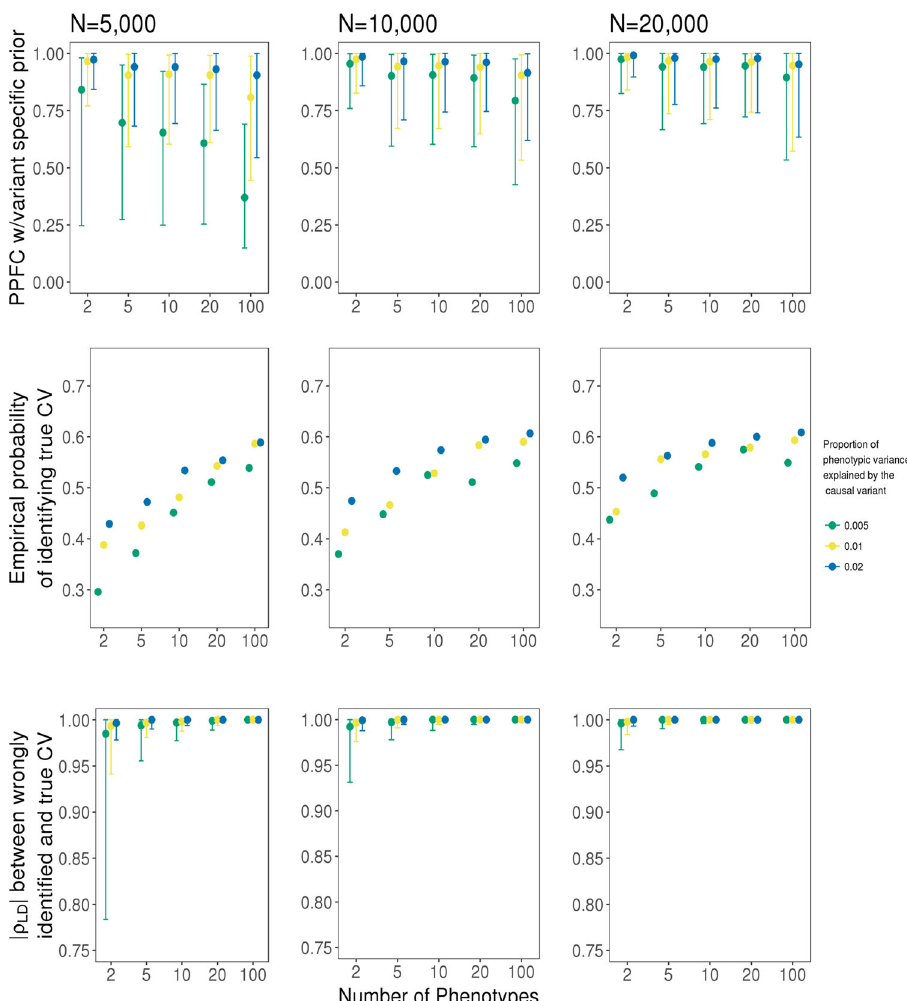
Fig. 4 Assessment of the HyPrColoc posterior probability. Simulation results for a sample size N ∈ {5,000, 10,000, 20,000} and a causal variant explaining {0.5%, 1%, 2%} of variation across m ∈ {2, 5, 10, 20, 100} traits. Presented is the distribution of the HyPrColoc posterior probability of full colocalization (PPFC) for variant-level priors only (top); the probability of correctly identifying the causal variant (middle) and; linkage disequilibrium between an incorrectly identi fi ed causal variant and the true causal variant (bottom). Error bars denote the 1st and 9th deciles and a point denotes the median value and performance was summarised from 1000 simulated datasets. Comparing performance across increasing study sample size and variance explained by the causal variant, power to detect all colocalized traits is reduced when including studies with smaller sample sizes (top row), however, including these studies can still boost the probability of correctly identifying the shared causal variant irrespective of variance explained (middle